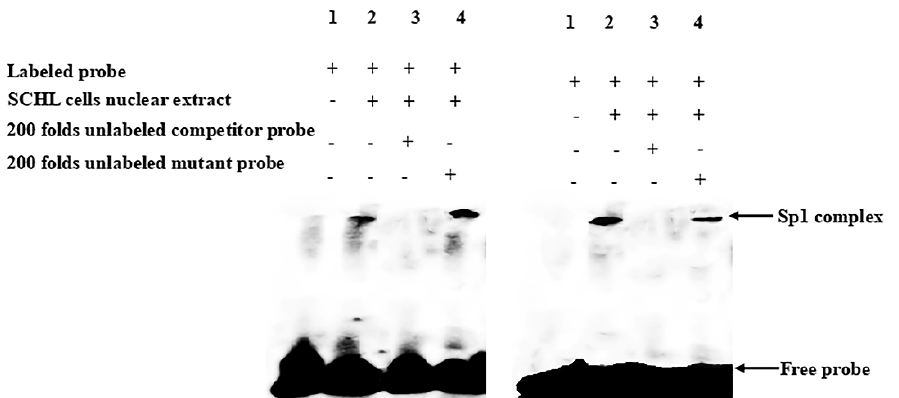
Figure 7. The electrophoretic mobility shift assay (EMSA) of ∆ 6 / ∆ 5 fads2 (left) and elovl5 (right) probes with S. canaliculatus hepatocytes nuclear proteins. Each lane is represented as lane 1, negative control; lane 2, nucleus proteins reactions; lane 3, unlabeled probe competing reactions; lane 4, unlabeled mutant probe competing reactions. “ + ” means that the corresponding material in the row has been added, and “ − ” means that the material is not added.